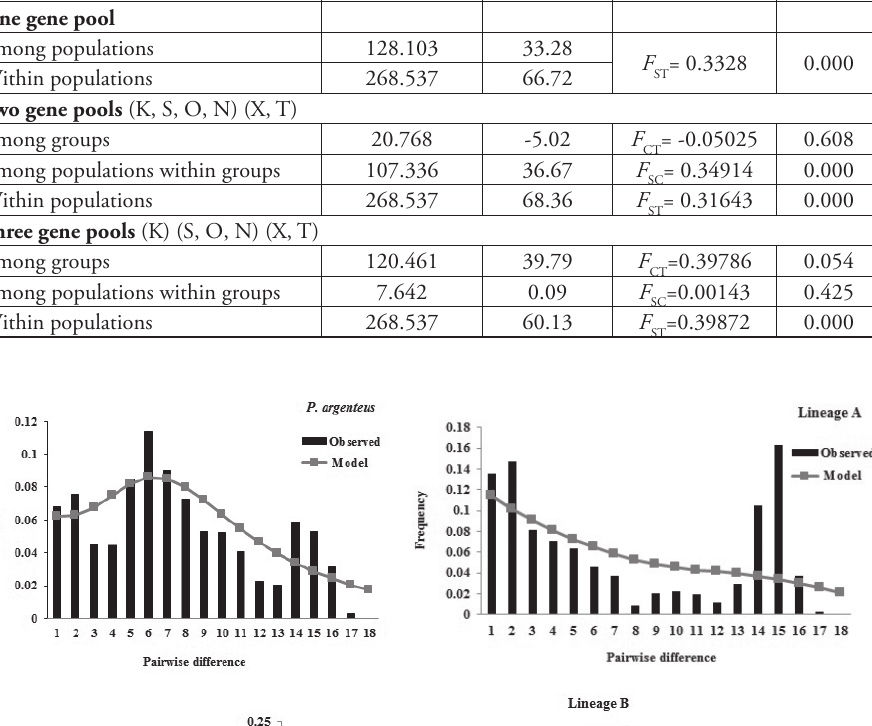
drial CR (5–10%/MY) and τ values, respectively. The ratio values ( θ mated the effective female population sizes after and before the expansion, were 2000 for lineage A and infinite for lineage B (Table